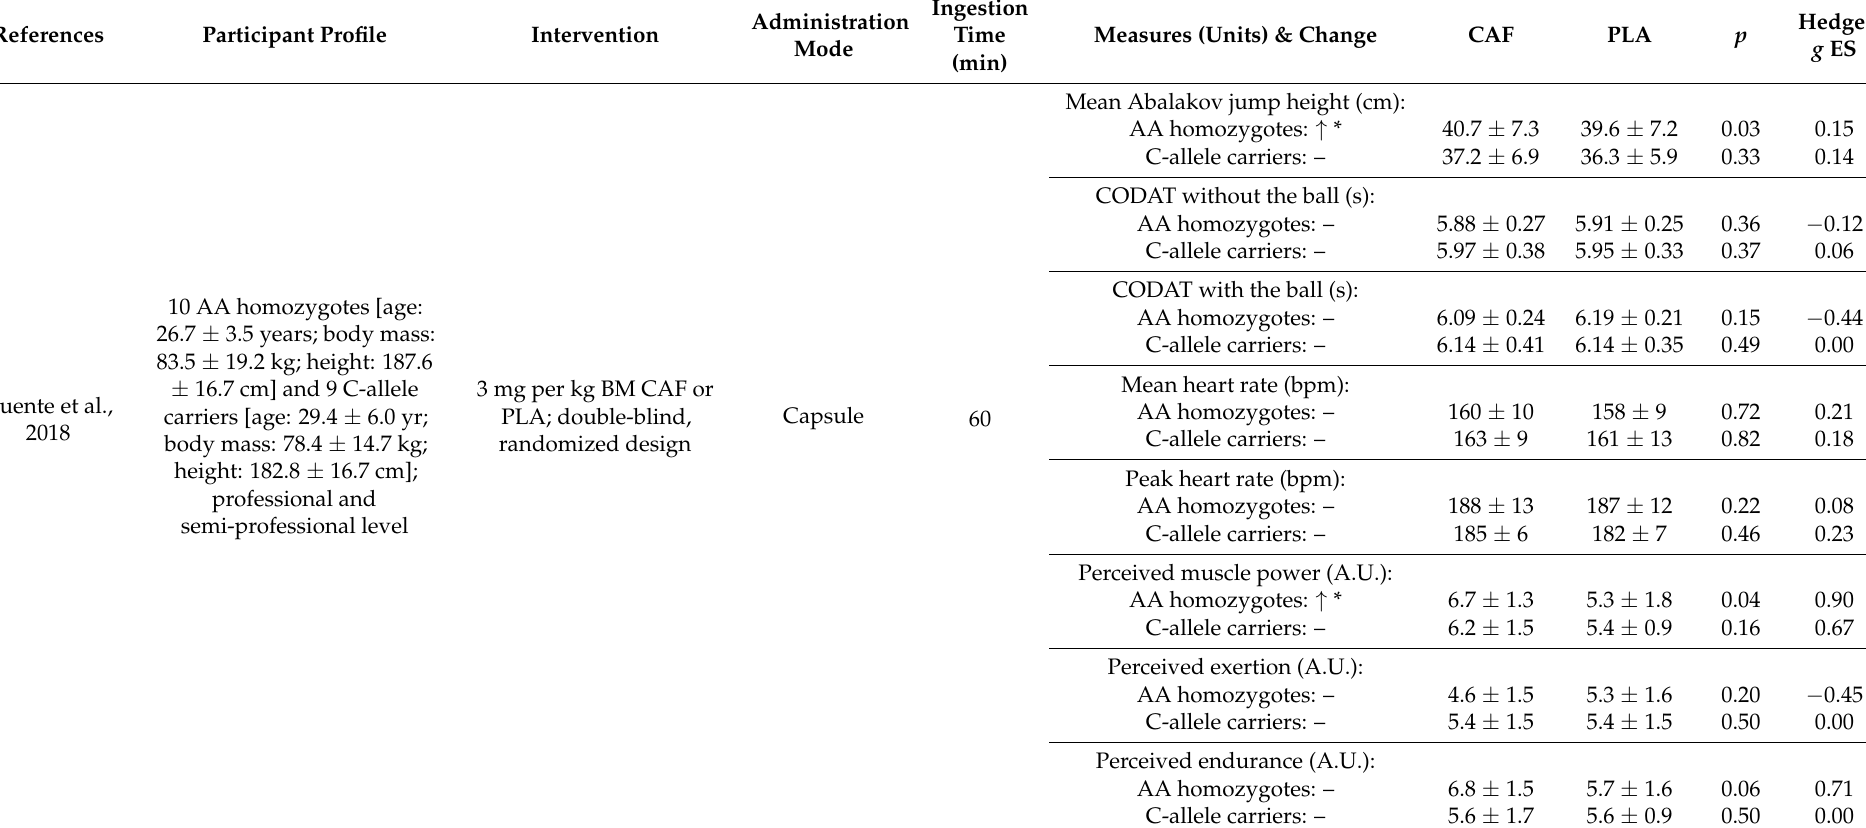
Table 5. Effect of caffeine on physical and basketball performance across different genetic